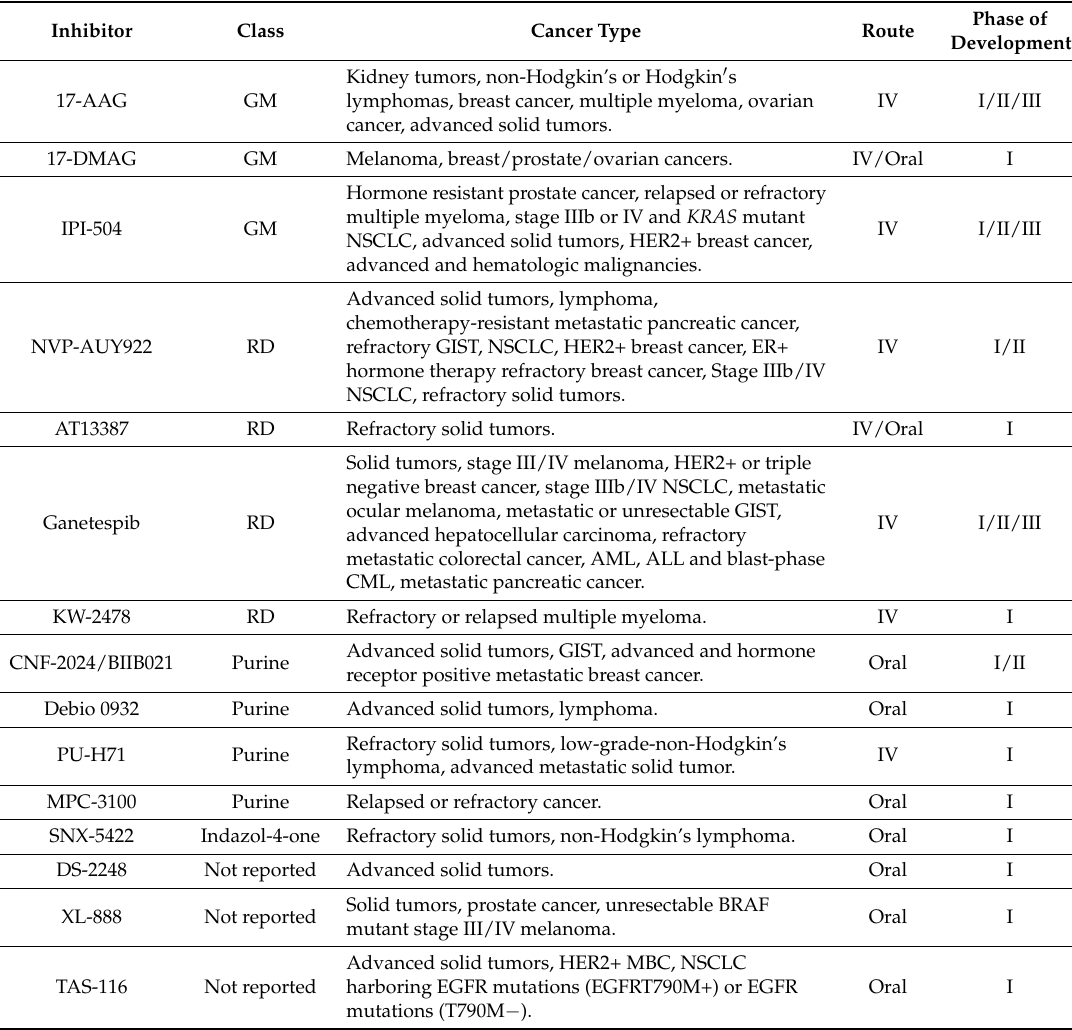
Table 3. HSP90 inhibitors as mono- or combination therapy in clinical